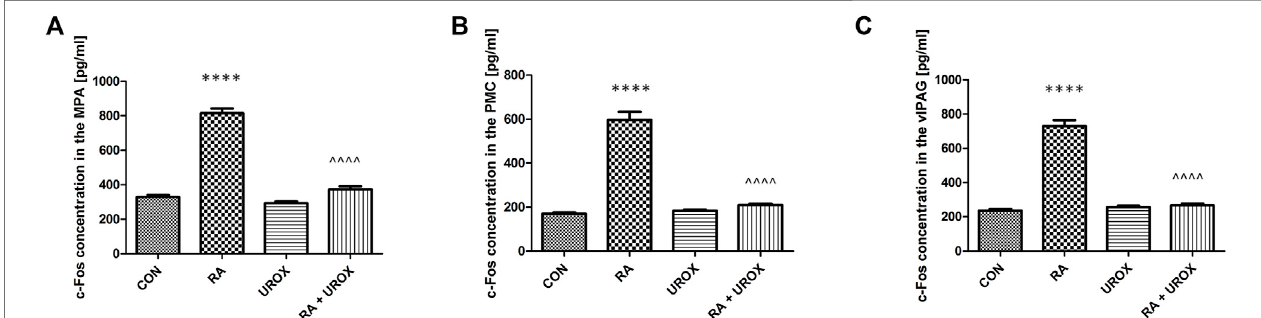
Values are expressed as the mean ± SEM; no statistically signi fi cant changes were observed.